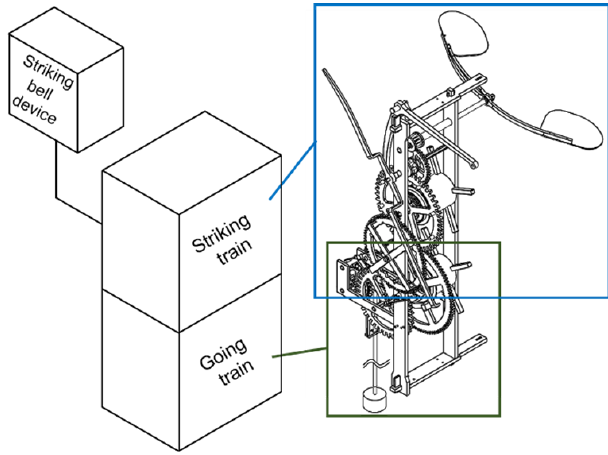
Figure 4. Structure of the Marston Magna clock